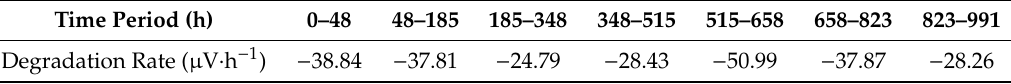
Table 8. PEMFC degradation rate at di ff erent time intervals during the